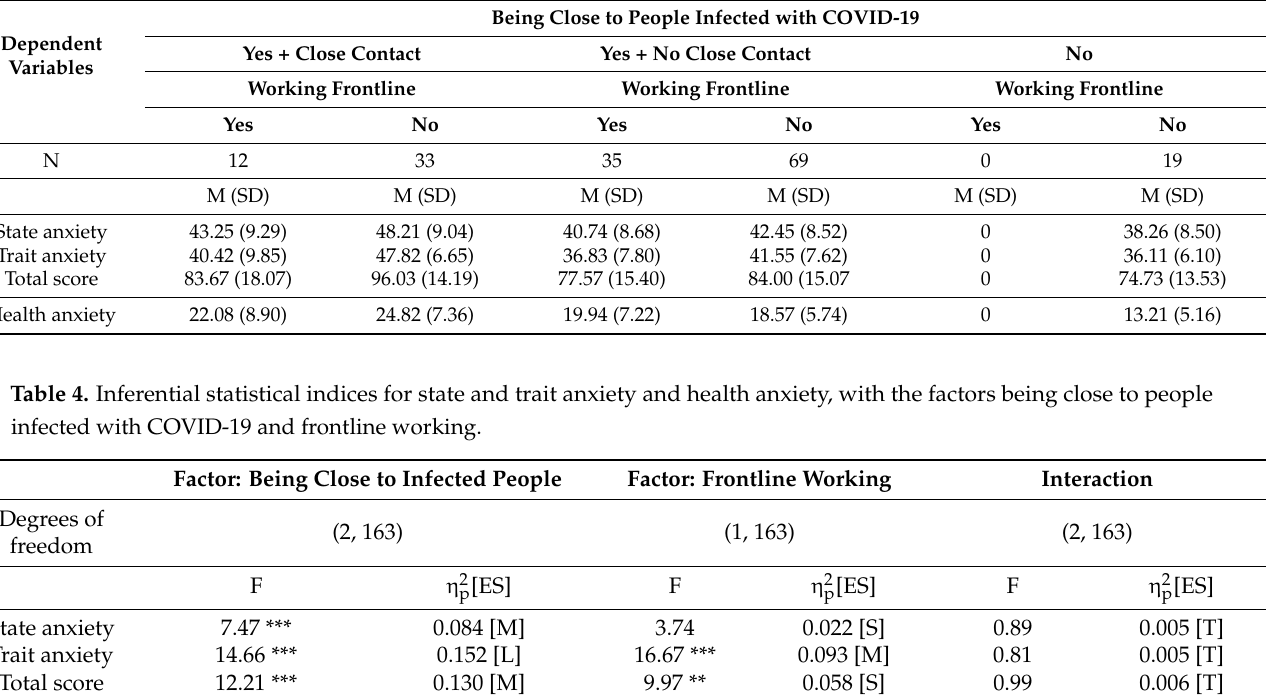
Table 3. Descriptive statistical indices of state trait anxiety and health anxiety, separately for being close to people infected with COVID-19 (yes + close contact; yes + no contact; no) and separately for working frontline (yes; no).